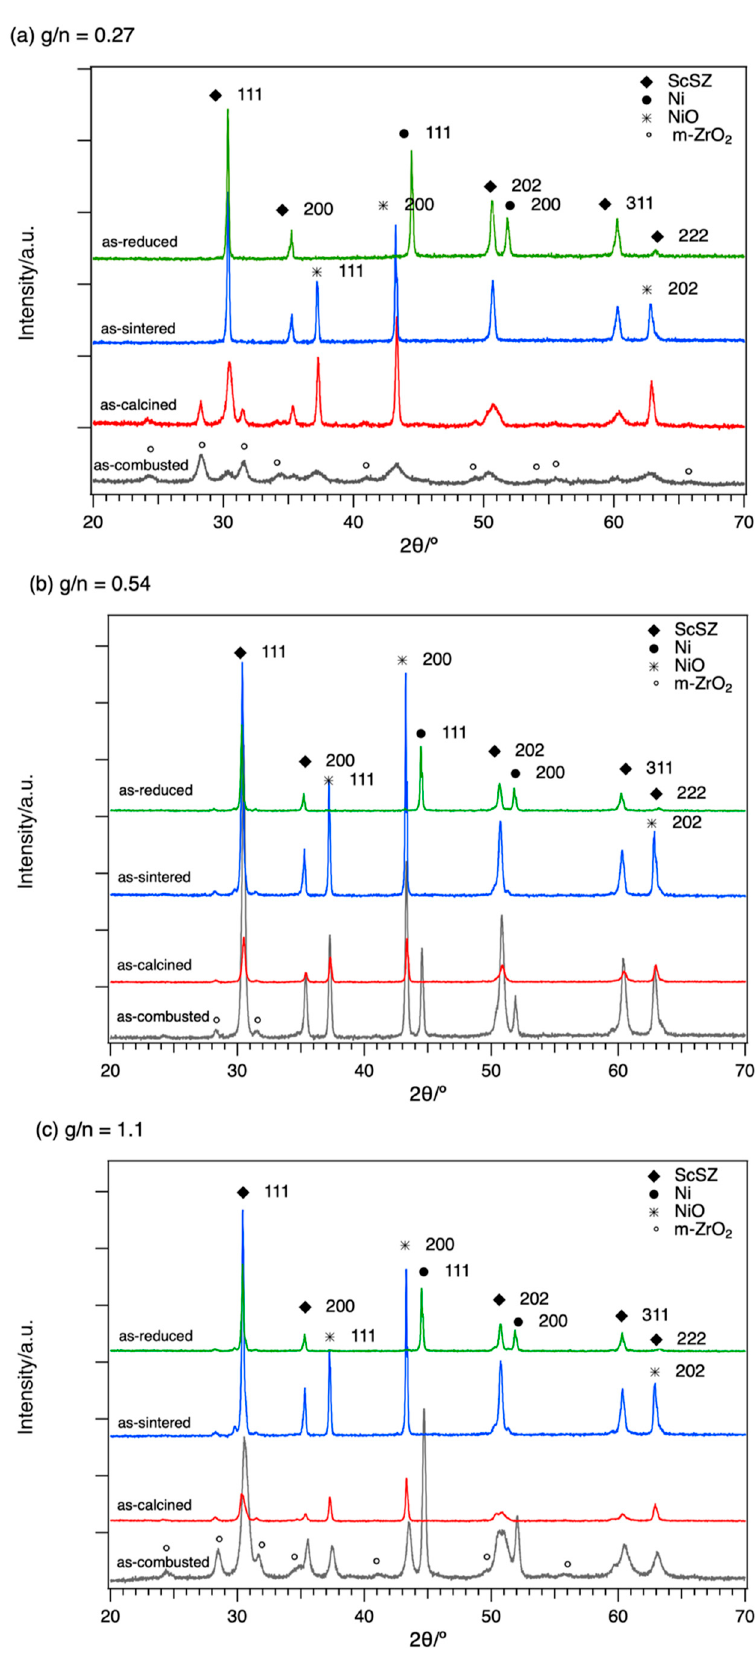
Figure 1. X-ray diffraction (XRD) stack patterns of the as-combusted, as-calcined, as-sintered NiO/ScSZ, and as-reduced Ni/ScSZ bulk pellets for g/n ratios of ( a ) 0.27, ( b ) 0.54, and ( c ) 1.1.